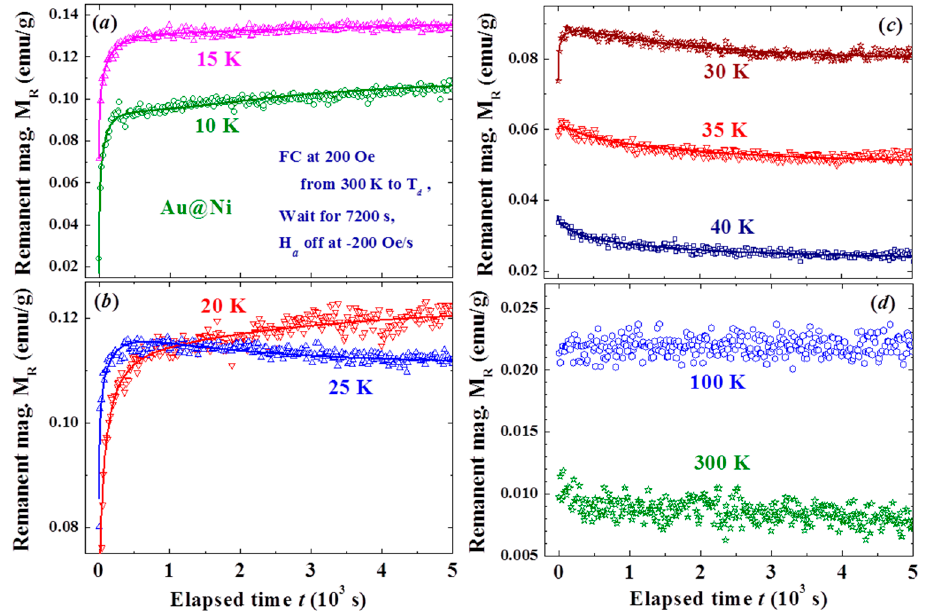
Figure 5. Time evolutions of the remanent magnetizations recorded after field-cooling at H a = 200 Oe from 300 K to nine representative temperatures of ( a ) 10 and 15 K; ( b ) 20 and 25 K; ( c ) 30 to 40 K; and ( d ) 100 to 300 K, followed by a wait of 7200 s before turning the H a off at a rate of − 200 Oe/s. The solid lines indicate the fits of the data to the stretched exponential decay profile discussed in text.